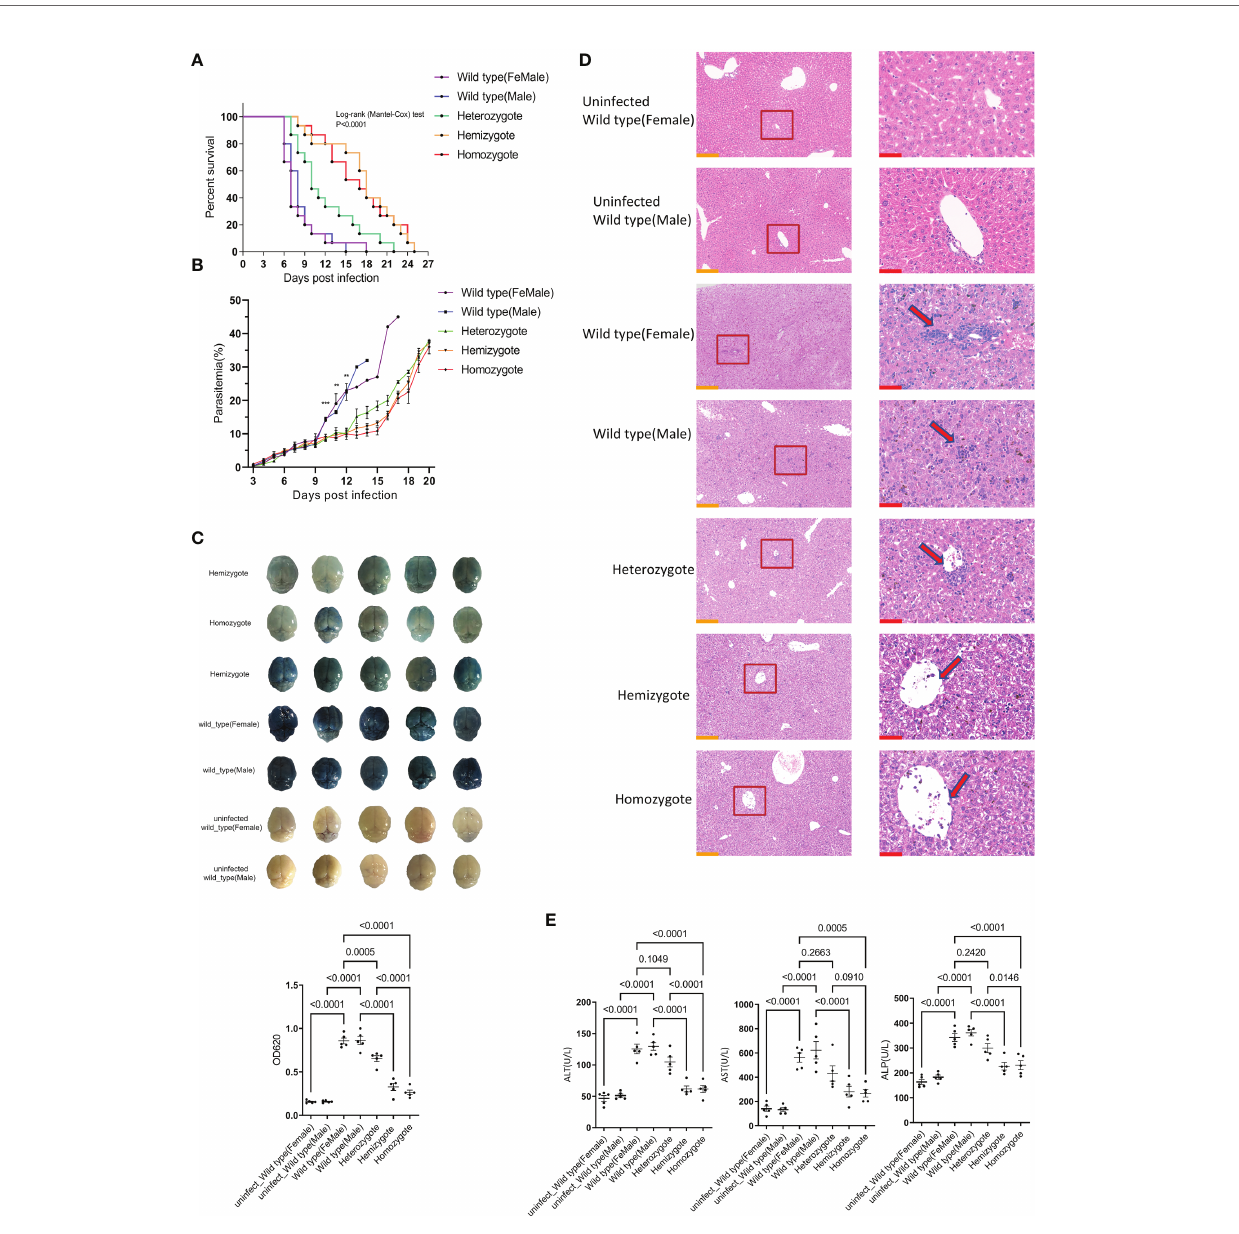
FIGURE 1 | G6pd-de fi cient mice infected with P.berghei showed milder complications compared to wild type mice. (A) Survival analysis of wild type and G6pd- de fi cient mice infected with P.berghe i. Mice were injected intraperitoneally with 10 6 pRBCs infected with P.berghei , infected mice were monitored daily for survival. (n=15/each group, data are combined from three independent experiments) (B) Dynamics change of parasitemia. Parasitemia was monitored until the mice died or day 20 post-infection. (C) Whole brains of Evans blue dye leakage in wild type and G6pd-de fi cient mice and quanti fi cation analysis of Evans blue dye extravasation in the brain using spectrophotometer. (n=5/each group, data are representative of three independent experiments) (D) Representative images of HE staining of the liver showed that the level of immune cell in fi ltration (arrows) was reduced in G6pd-de fi cient mice infection with P.berghei on day 7 post-infection. The contents present in the red box are indicative of the high magni fi cation observation of the display. Yellow scale bars, 200 m m; Red scale bars,50 m m. (n=5/each group, data are representative of three independent experiments) (E) Serum enzymatic indicators showed that G6pd-de fi cient mice had less liver injury in response to P.berghei infection compared to wild type mice on day 7 post-infection. (n=5/each group, data are representative of three independent